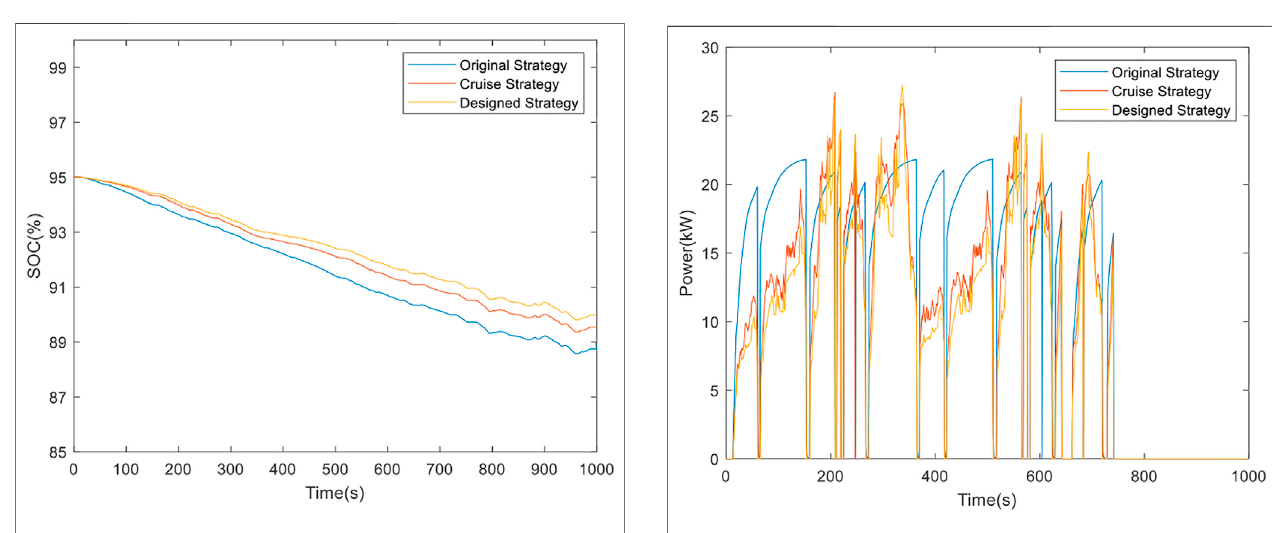
FIGURE 13 | Comparison of power consumption of operating